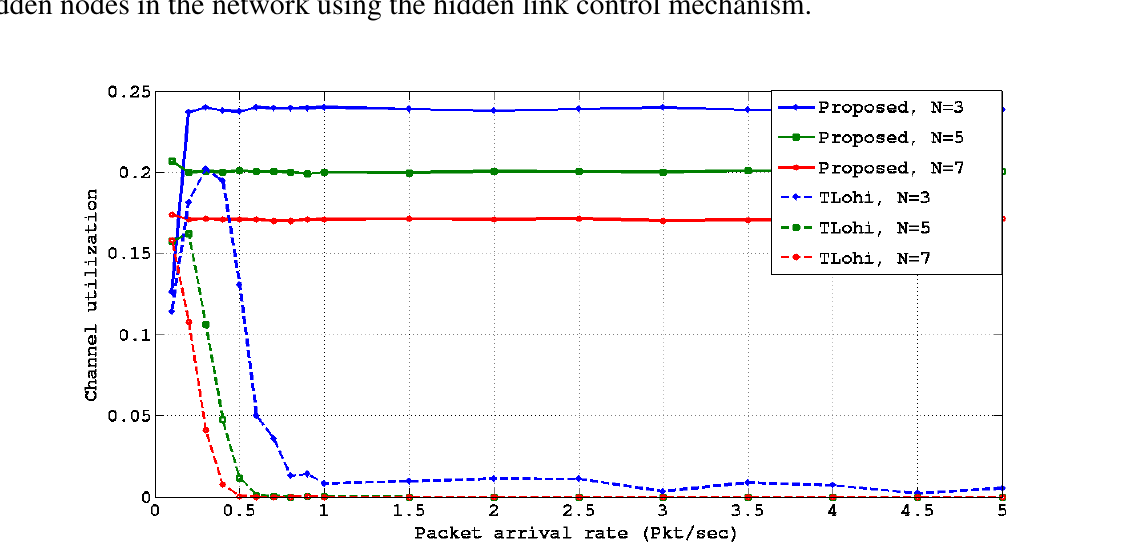
Figure 10. Comparison between T-Lohi and the proposed